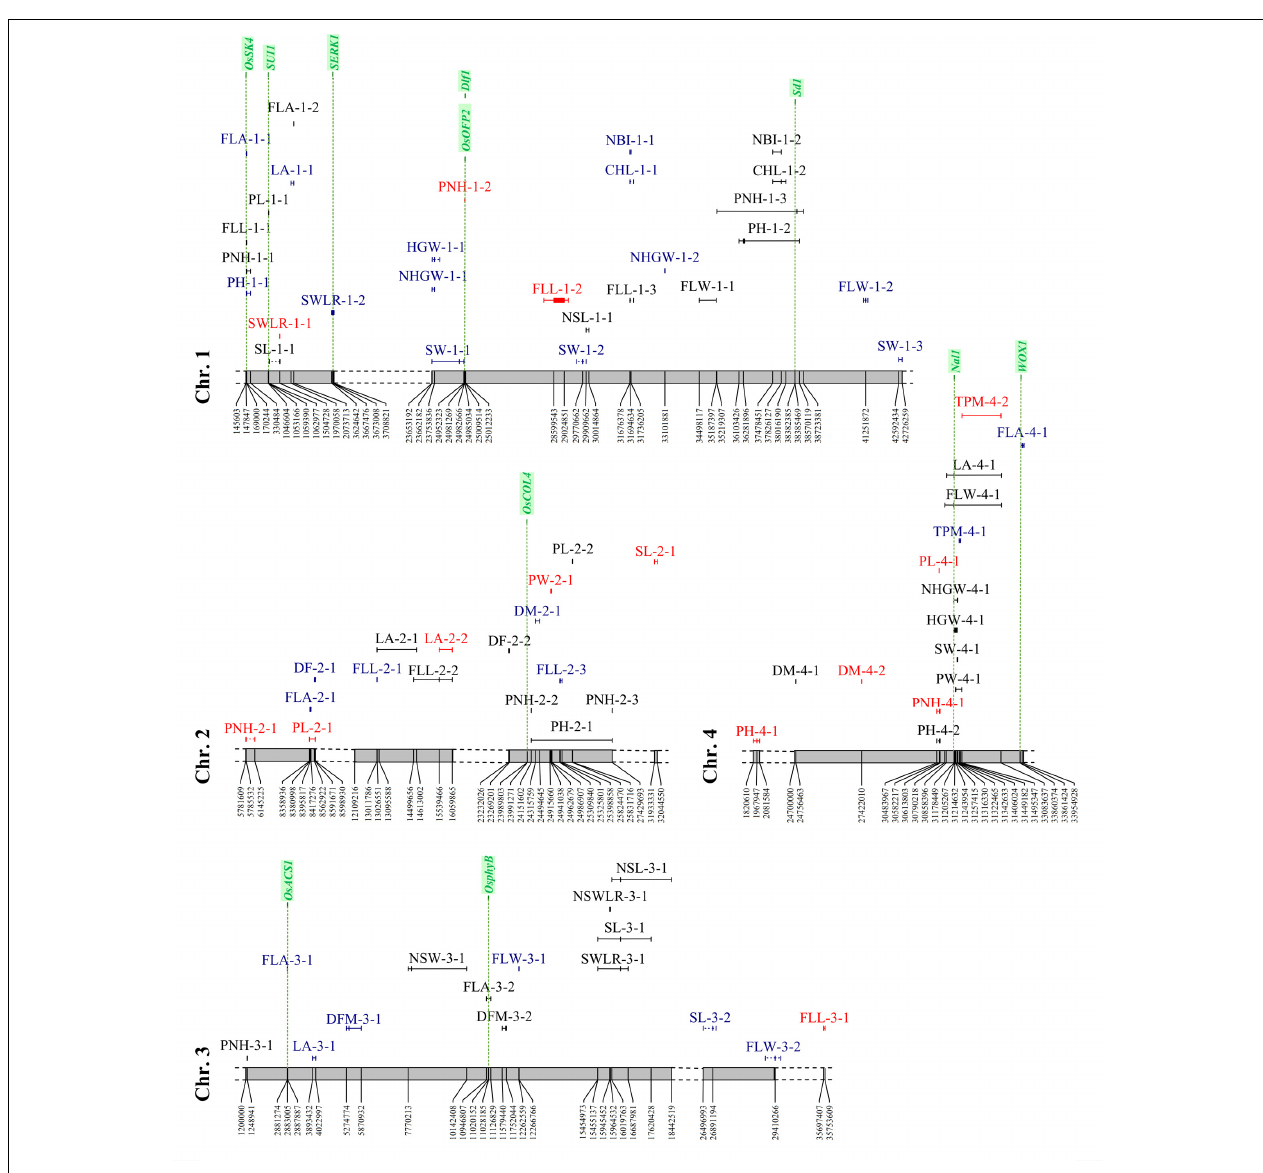
FIGURE 6 | Distribution of the significant associations detected on chromosomes 1 to 4, as indicated in Supplementary Tables S2 and S3 (sheet 1). Acronyms of the traits are as indicated in Table 1 . Associations LW-specific, PF-specific and common to both watering treatments are represented in red, blue, and black, respectively. Candidate gene locations are shown as green vertical dashed lines with names on